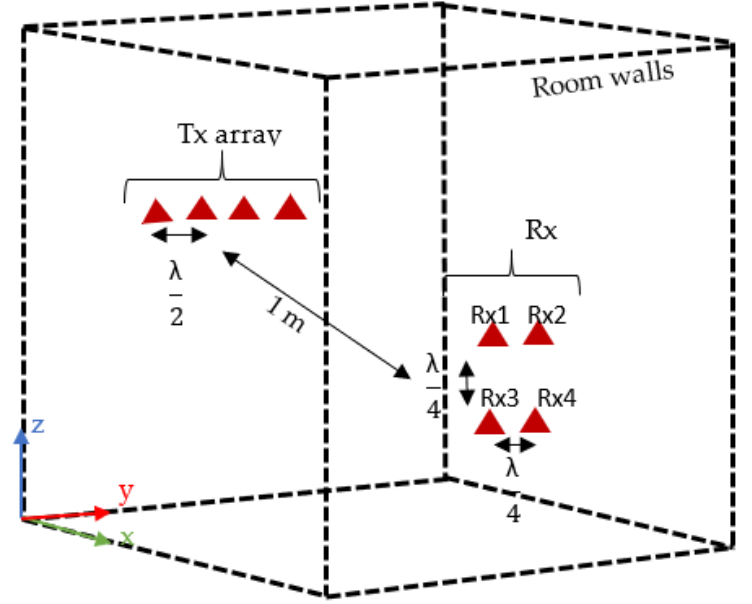
Figure 8. 2 × 2 Rx array configuration for MIMO system. Table 3. Average received power in watts.